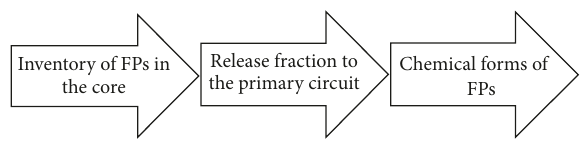
Figure 1: The flowchart of the methodology.